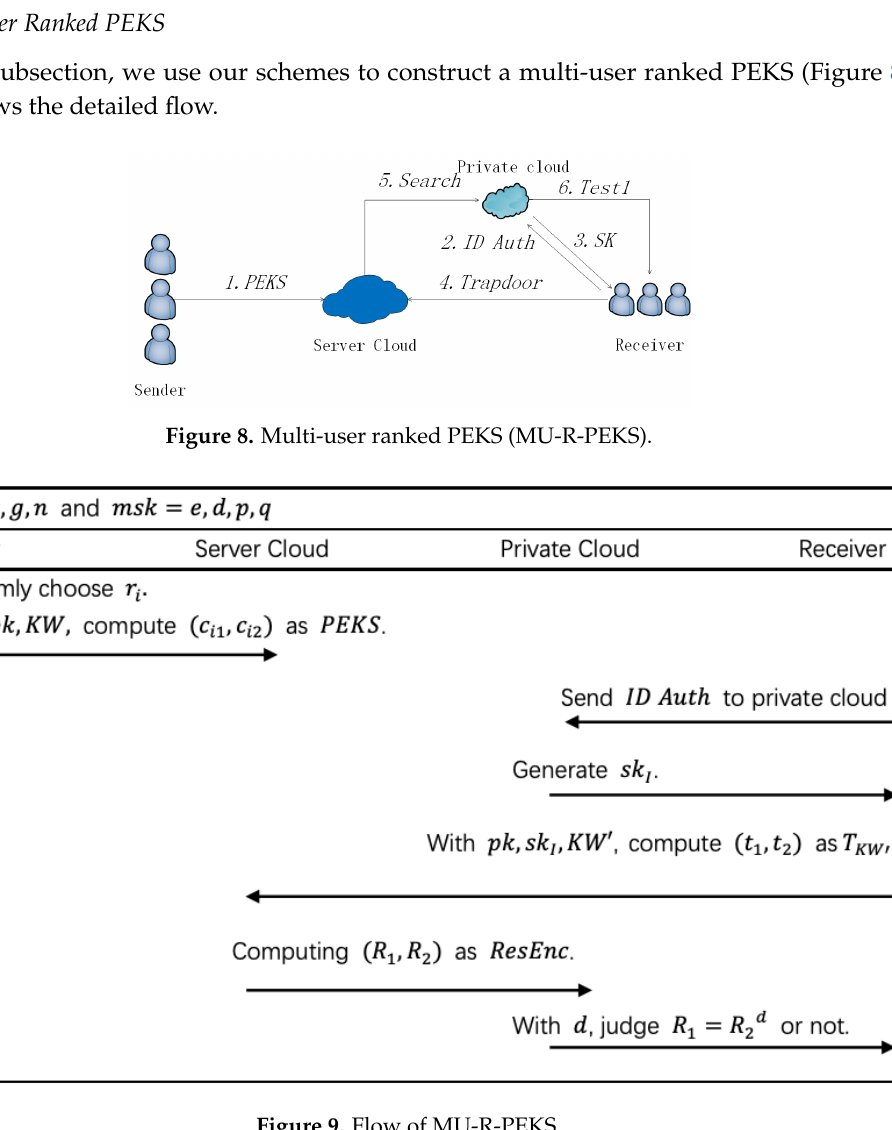
Figure 9. Flow of